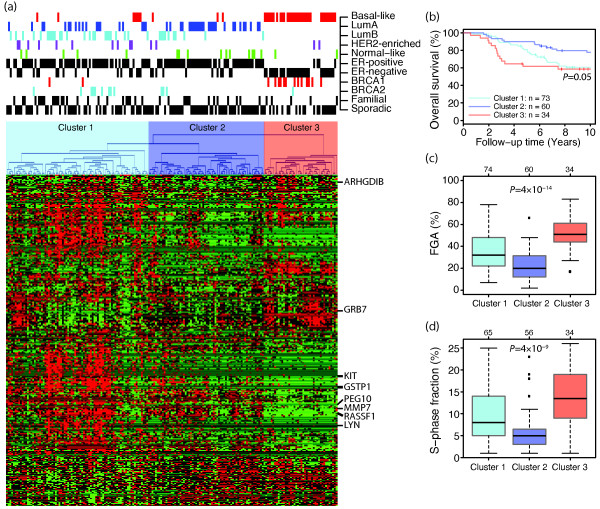
Unsupervised clustering of 189 tumours based on the 332 most variably methylated CpGs. (a) Hierarchical clustering. The heatmap shows relative methylation levels (red, more methylated; green, less methylated). Clustering results in three clusters associated with lumB, lumA and basal-like tumours, respectively. (b) Kaplan-Meier demonstrating longest survival in lumA-associated Cluster 2 and shortest in basal-like-associated Cluster 3. P-value was calculated using log-rank test. (c) Fraction of genome altered (FGA) highest in basal-like-associated Cluster 3 and lowest in lumA-associated Cluster 2. P-value was calculated using analysis of variance (ANOVA). (d) S-phase fraction highest in basal-like-associated Cluster 3 and lowest in lumA-associated Cluster 2. P-value was calculated using ANOVA. The number of tumours in each subtype is shown at top.